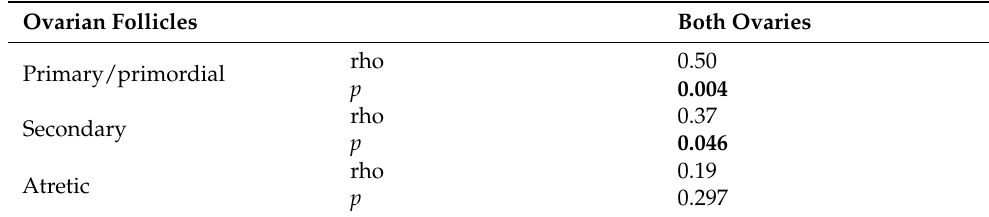
Table 3. Spearman’s correlation coefficients of ovarian volume with the number of any type of cells.